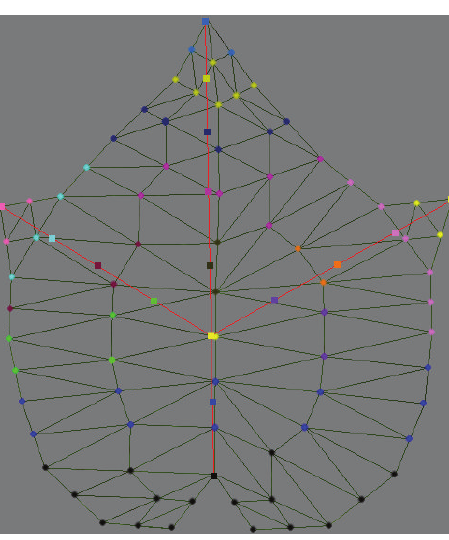
Figure 3: Example of banding a leaf mesh to its venation skeleton.